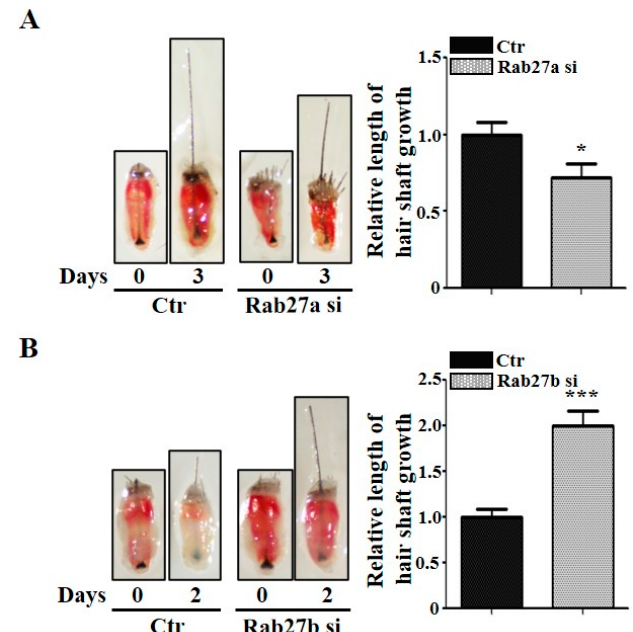
Figure 3. Rab27a and Rab27b have opposite effects in mouse vibrissae. ( A ) When Rab27a siRNA was treated with mouse vibrissae for 3 days, it suppressed the growth of the hair shaft compared with the control. ( B ) On the other hand, inhibition by Rab27b siRNA promoted the hair shaft growth of mouse vibrissae and grew nearly twice as much as the control in 2 days. Ctr; control, si; siRNA, DP; dermal papilla. * p < 0.05, *** p < 0.001 using Student’s t test. n = 10 per group. Three independent experiments were conducted. All error bars indicate S.E.M.